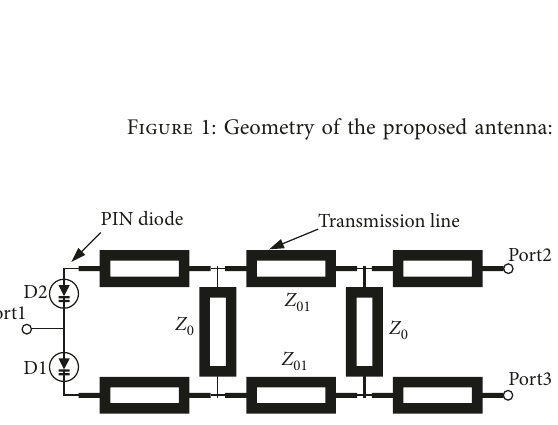
Figure 2: Schematic diagram of the reconfigurable feeding network. Figure 6. The optimized antenna parameters are shown in Table 1.